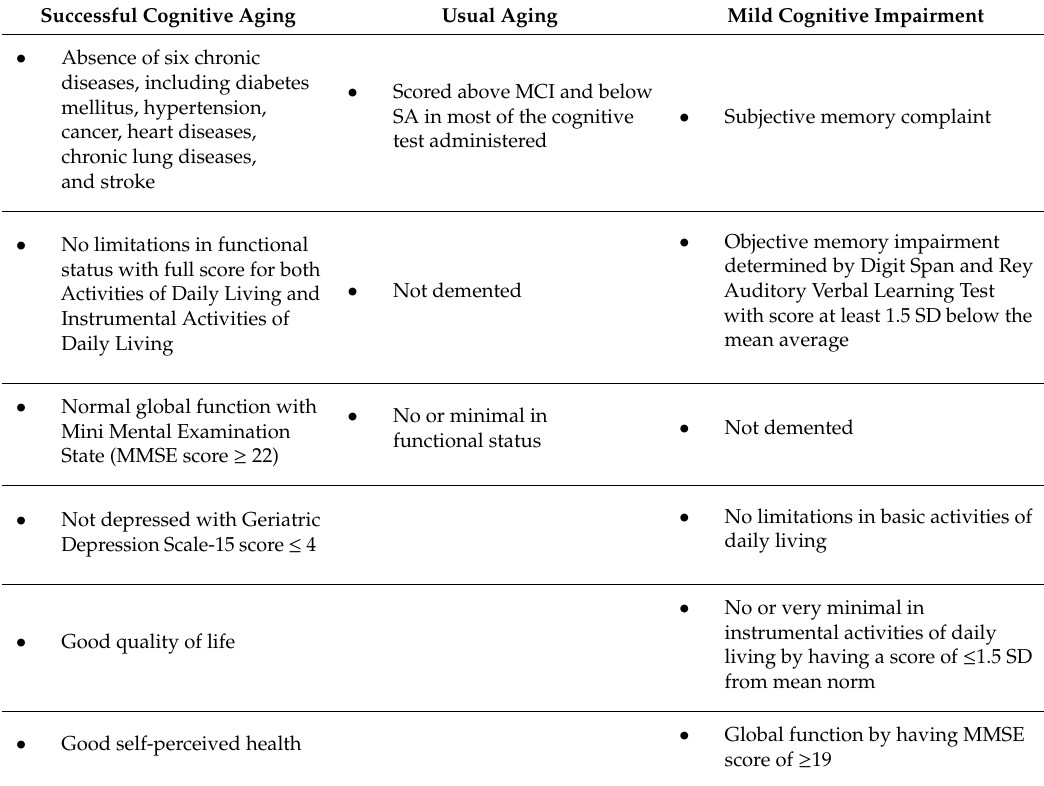
Table 1. Classification of aging groups